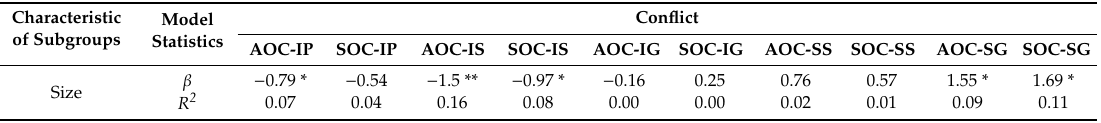
Table 2. Results of regression analysis of associations between informal subgroup size (independent variables) and conflict levels and types (dependent variables) in the context of the